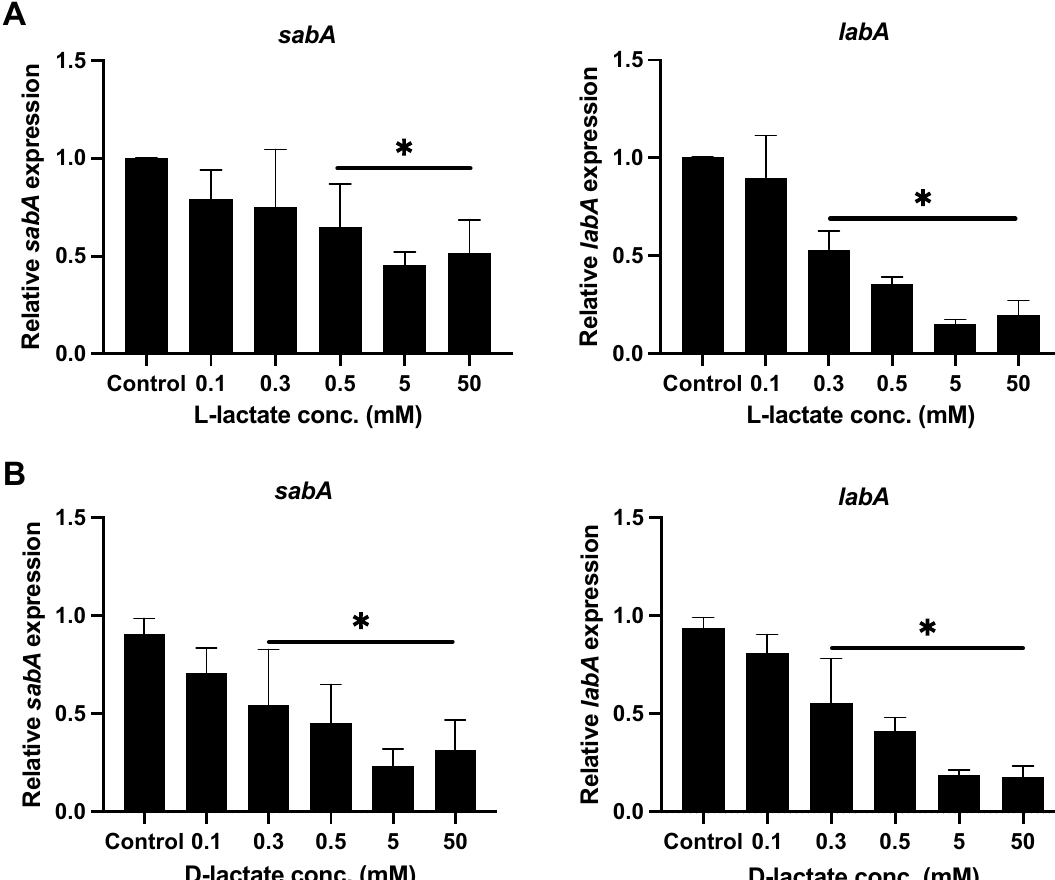
Figure 2. Gene expression of sabA and labA in the presence of different concentrations of l- and d-lactate. Relative expression levels of the H. pylori adhesin genes sabA and labA after incubation of the bacteria in RPMI 1640 medium without glucose (control) or supplemented with various concentrations of either l-lactate ( A ) or d-lactate ( B ) for 2 h. Target gene expression was normalized against that of the housekeeping gene gyrB . Gene expression levels in the control were set to 1. Data represent the means and standard deviation of duplicate samples and the average of three independent experiments. *P < 0.05; ns, nonsignificant, using ANOVA followed by a Bonferroni